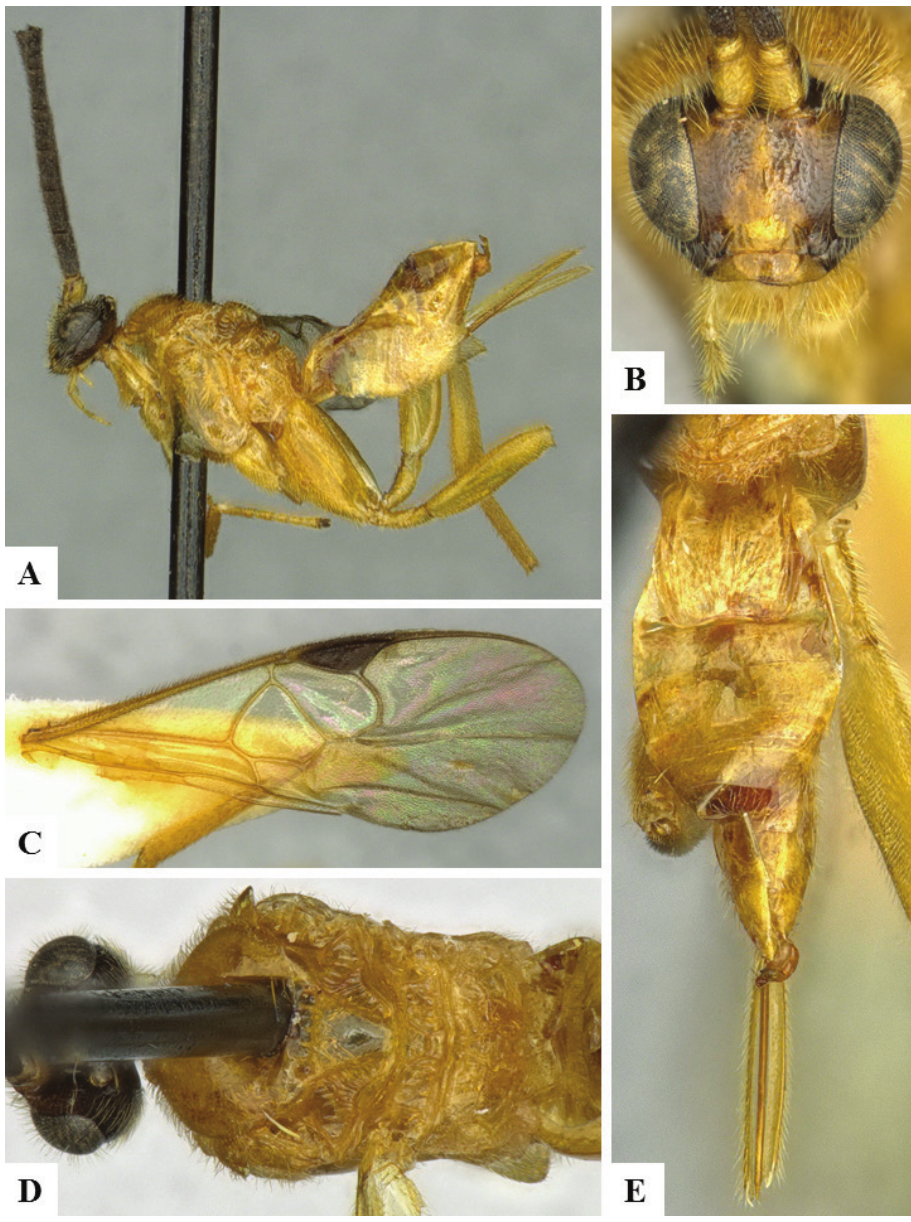
Figure 12. Carlmuesebeckius smithsonian female holotype. A Habitus B Head frontal C Fore wing D Mesosoma dorsal E Metasoma, ovipositor and ovipositor sheaths, dorsal. Male. Unknown. Biology. Host unknown. Distribution.